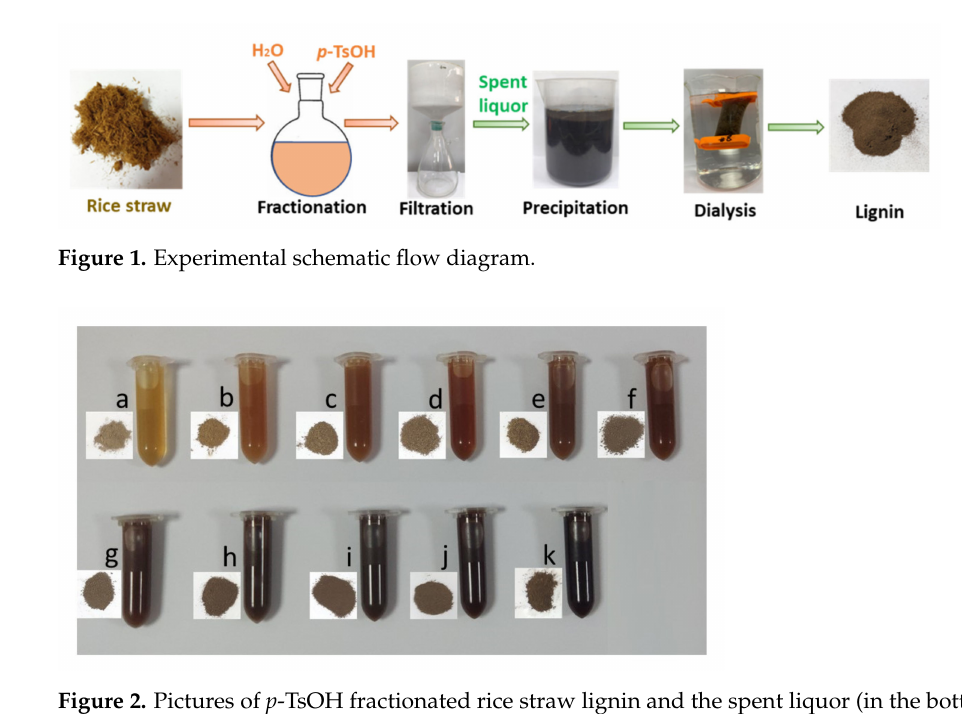
Figure 2. Pictures of p -TsOH fractionated rice straw lignin and the spent liquor (in the bottles). ( a )